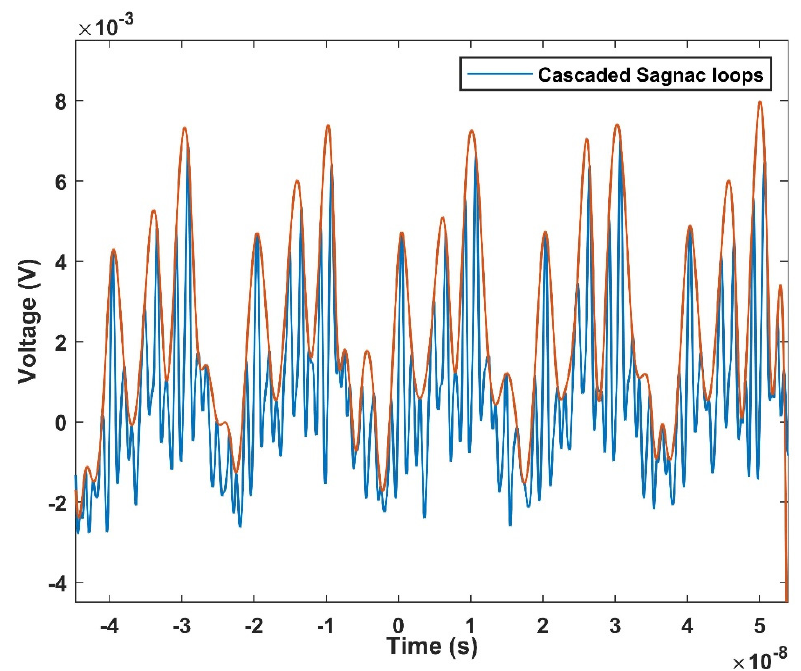
Figure 4. The output spectrum of the cascaded Sagnac ring in time domain.